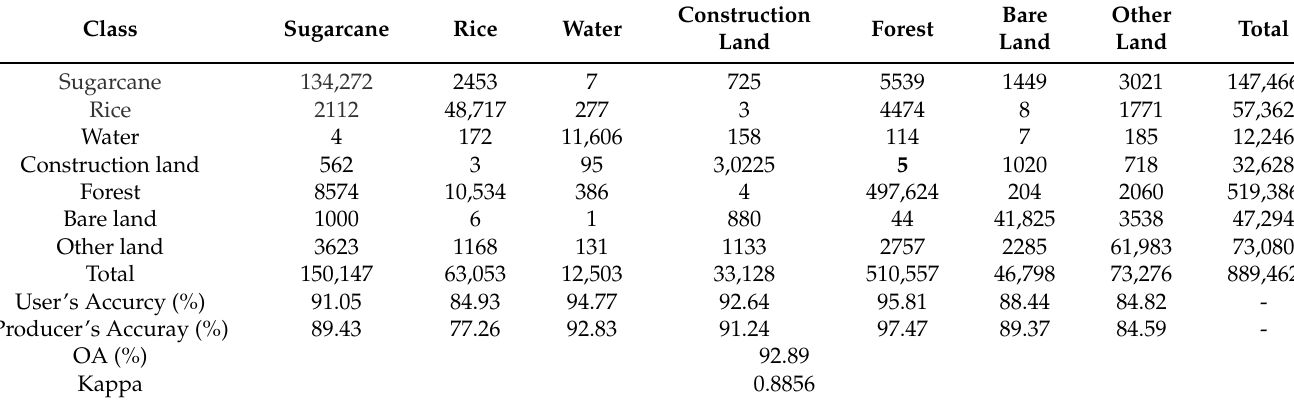
Table 8. Mixing matrix of the validation set based on the algorithm proposed in this